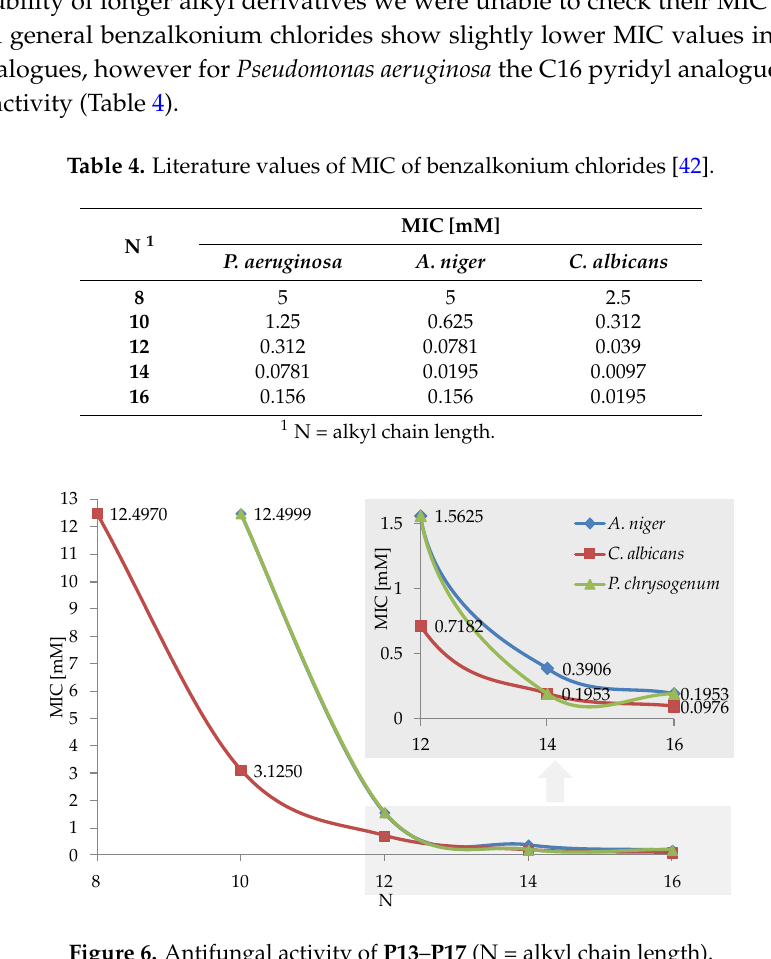
Figure 6. Antifungal activity of P13 – P17 (N = alkyl chain length).